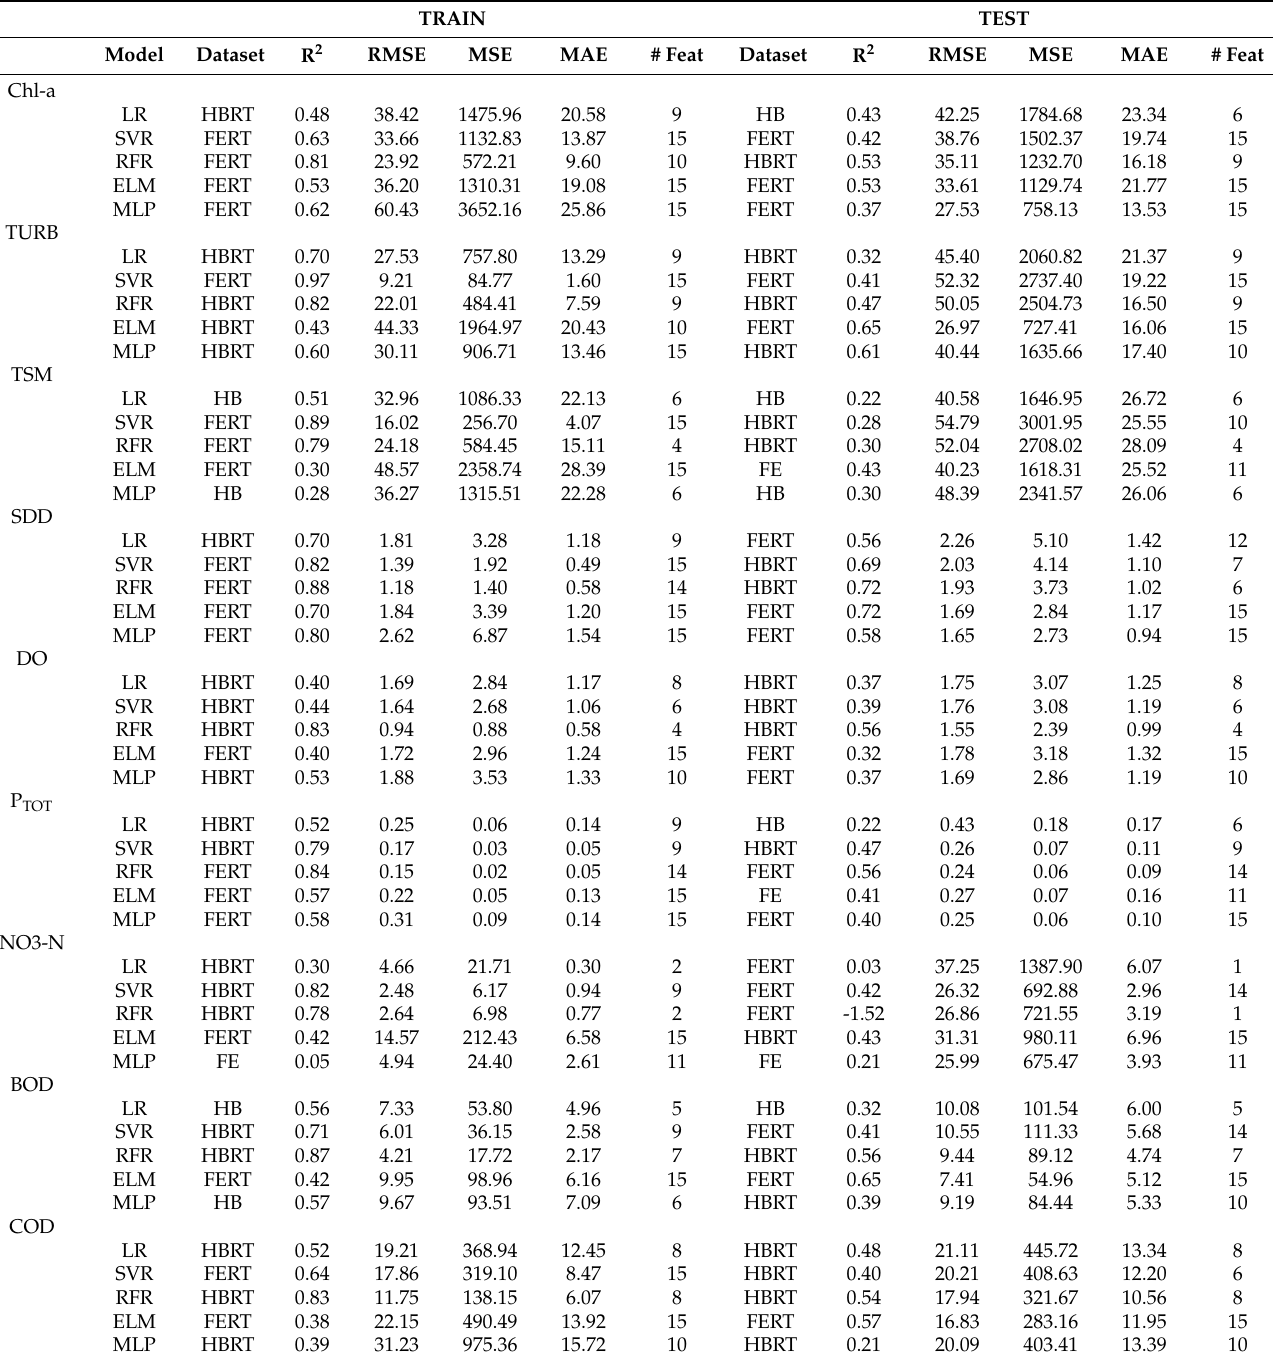
Table 8. Summary of the best performing dataset for all models and all parameters in train and test stages. Acronyms and units are as follows: chlorophyll-a (Chl-a: mg/L); turbidity (TURB: NTU); total suspended matter (TSM (mg/L); Secchi disk depth (SDD: m); dissolved oxygen (DO: mg/L); total phosphorus (P TOT : mg/L); nitrate (NO3-N: mg/L); biochemical oxygen demand (BOD: mg/L); chemical oxygen demand (COD: